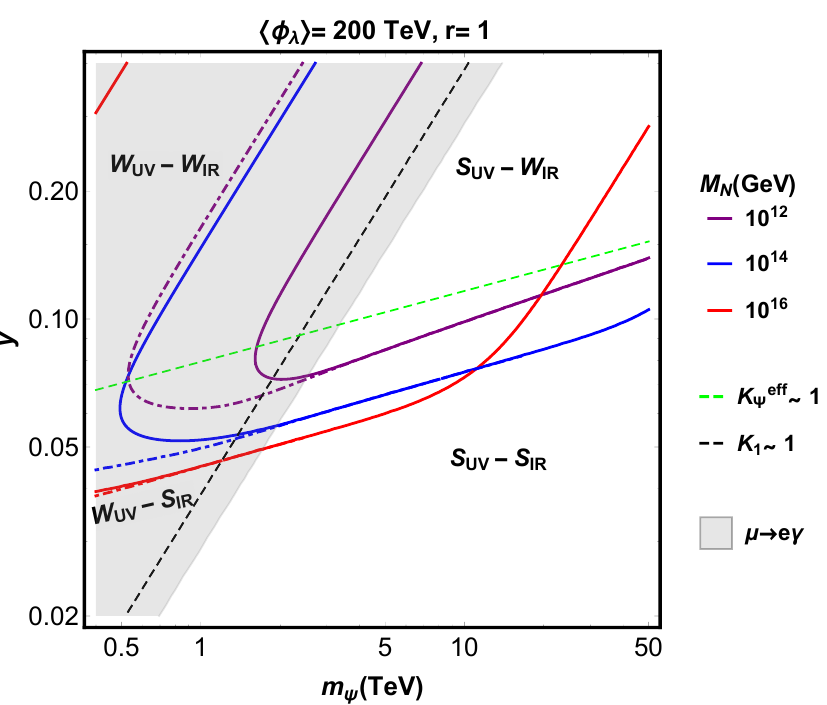
Figure 5 . Interplay of high-scale washout and asymmetry generation with TeV scale washout. Solid (dot-dashed) curves are contours on which observed baryon asymmetry and SM neutrino masses are produced for (cid:12)xed r and (cid:8) (cid:21) and di(cid:11)erent choices of M N , assuming zero (thermal) h i initial abundance for N . The dashed green line sets the boundary between the weak washout and strong washout regimes in the IR (around the TeV scale), and the dashed black line is the boundary of weak and strong washout regimes in UV. The gray shaded region is constrained by (cid:22) e(cid:13) !